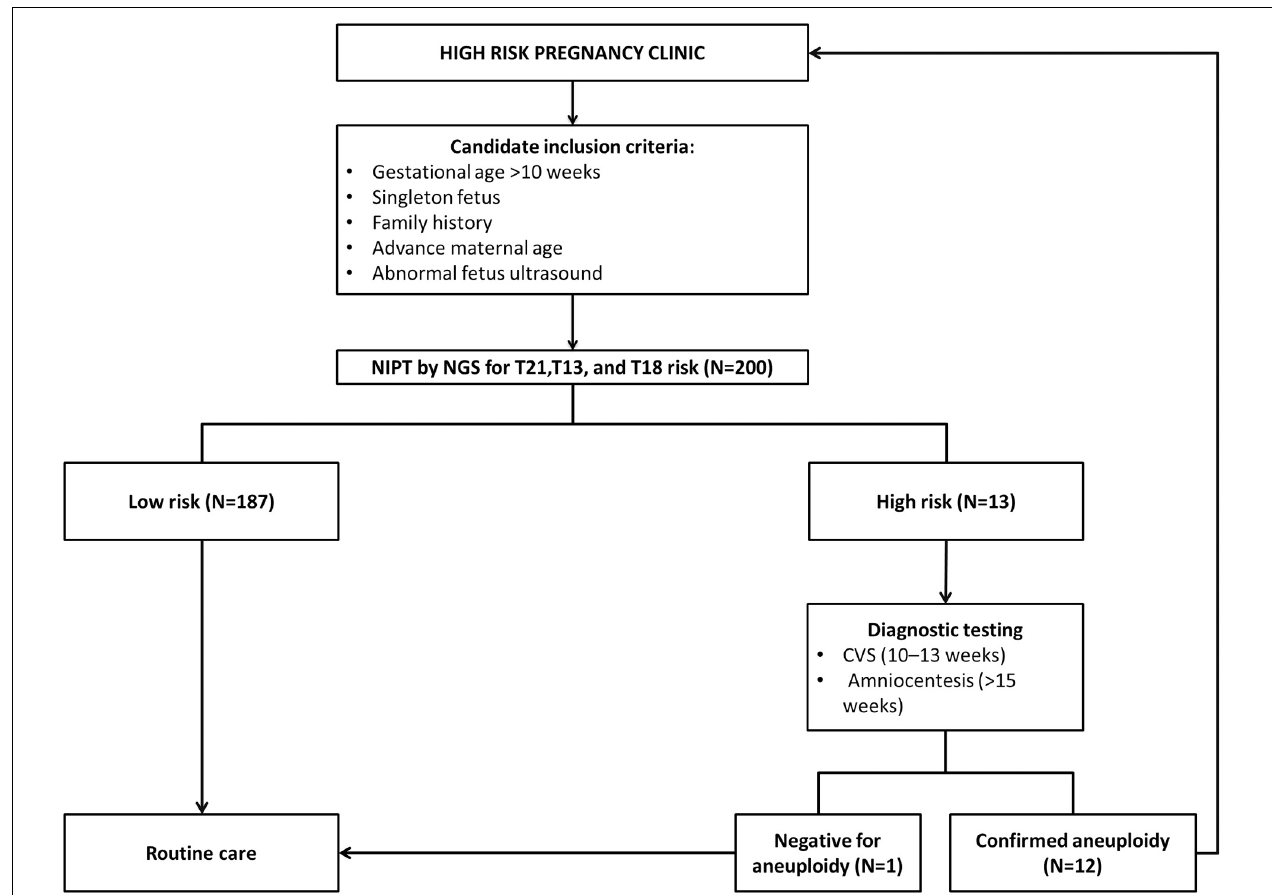
FIGURE 3 | Study summary for all the NIPT recruited